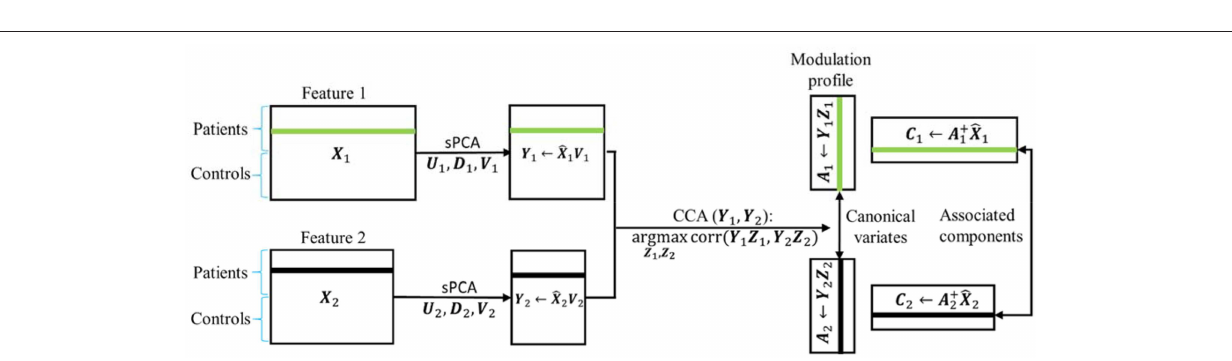
FIGURE 2 | Flow chart of sPCA + CCA. sPCA was carried out reduce data dimensions and to suppress irrelevant features. Then, CCA was carried out for fusion analysis to obtain modulation profiles and associated components. In the flow chart from